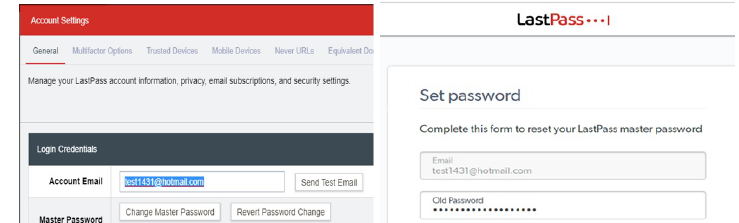
Figure A10. LastPass use different words for the same action, change master password and set master password (no consistency).